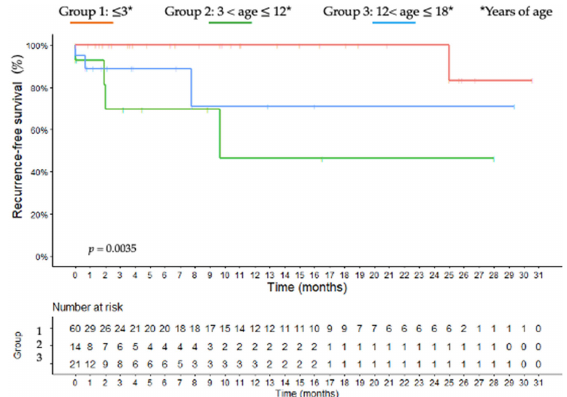
Figure 6. Kaplan ‐ Meier curve estimates for recurrence ‐ free survival according to each age ‐ group; group 1: ≤ 3 years of age; group 2: 3 < age ≤ 12 years of age; group 3: 12 < age ≤ 18 years of